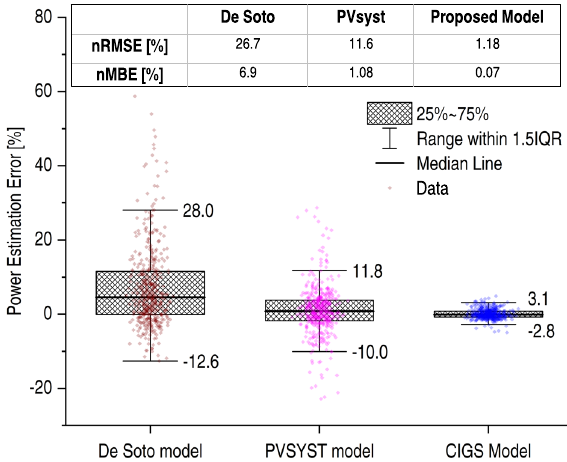
Fig. 8 Comparison of accuracy of the developed model (blue) with that of the De Soto (brown) and PVsyst (magenta) models. The graph contains error estimates of all considered operating points in the ranges of 25 °C to 65 °C and 100 W m − 2 to 1200 W m − 2 for eight CIGS modules. The checked boxes show the middle 50% of the data points (i.e., the range between the 25th and 75th percentile). The whiskers represent data points outside the middle 50% and within 1.5 times the interquartile range (IQR). The inset table shows the nRMSE and nMBE error for each of the model.